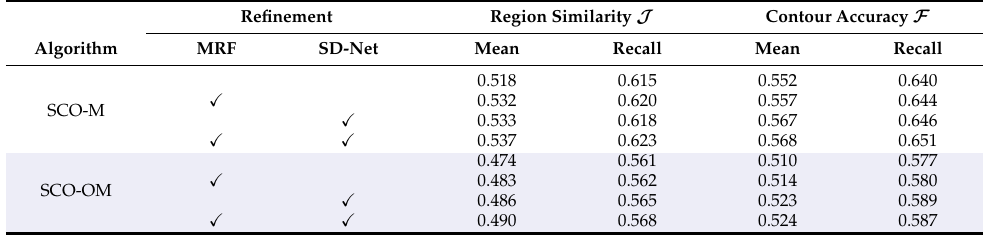
Table 2. Ablation studies on the validation set in DAVIS2017 according to the refinement methods.